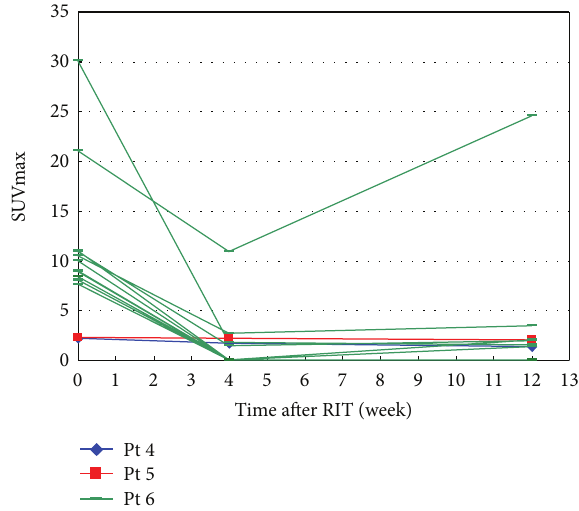
Figure 1: Changes in SUV max as a function of time after RIT lesion in patients 1–3 and 7. Figure 2: Changes in SUV lesion max as a function of time after RIT in patients 4–6.